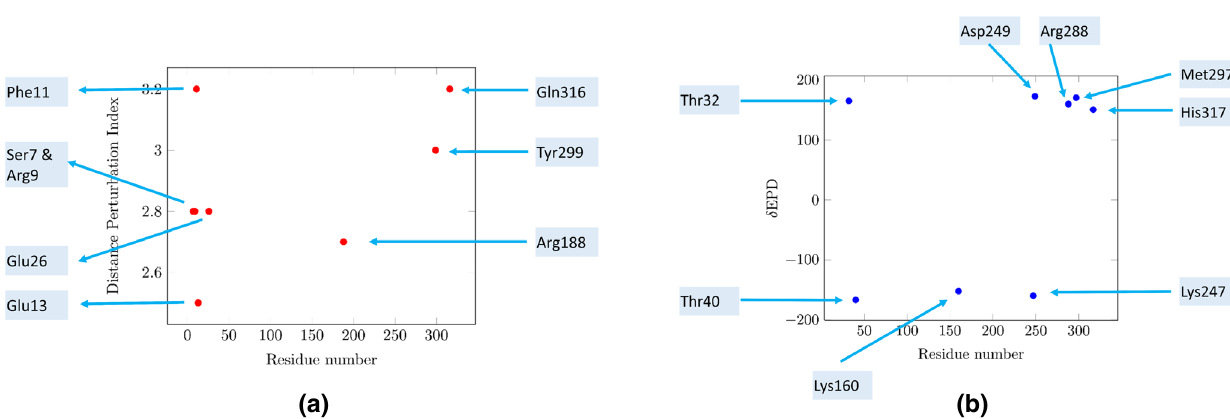
Figure 4. Spatial and electrostatic perturbations in the post-fusion DENV2-E protein analyzed using MEPP. MEPP analyzes the spatial and electrostatic potential difference (EPD) deviations of each residue with respect to other residues in close proximity (< 6Å). ( a ) Distance deviation. Barring Ser7, all residues are completely conserved in ZIKV and DENV. All residues, barring Gln316, are known epitopes. Gln316 precedes the histidine residue responsible for initiating pH driven conformational changes during cell entry. ( b ) Electrostatic perturbation. Several residues identified by electrostatic features do not have known references as epitopes in current literature. Thr32 and Thr40 are two such residues, which are conserved in these flaviviruses.